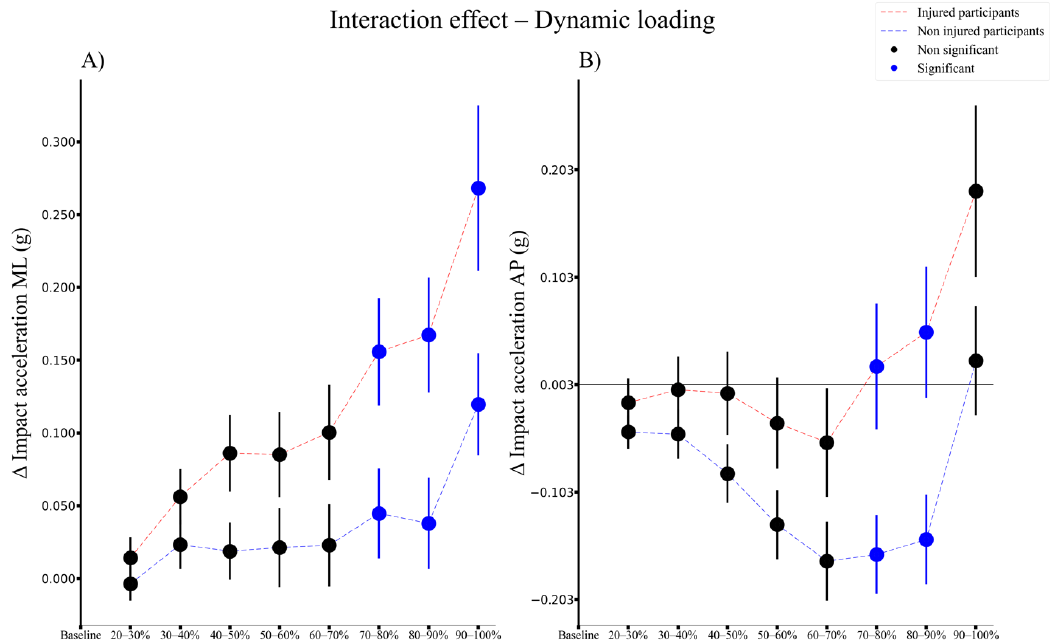
Figure 6. Time series of the overall significant interaction effects (represented by blue dots) for changes in dynamic loading measures (Change from baseline in peak impact acceleration in ( A ) mediolateral direction and ( B ) anterioposterior direction) for subjects that sustained an injury (red dashed lines) and subjects that would not (blue dashed lines), with differences relative to the baseline (first percent of the Cooper test). ML, mediolateral, AP, anteroposterior.